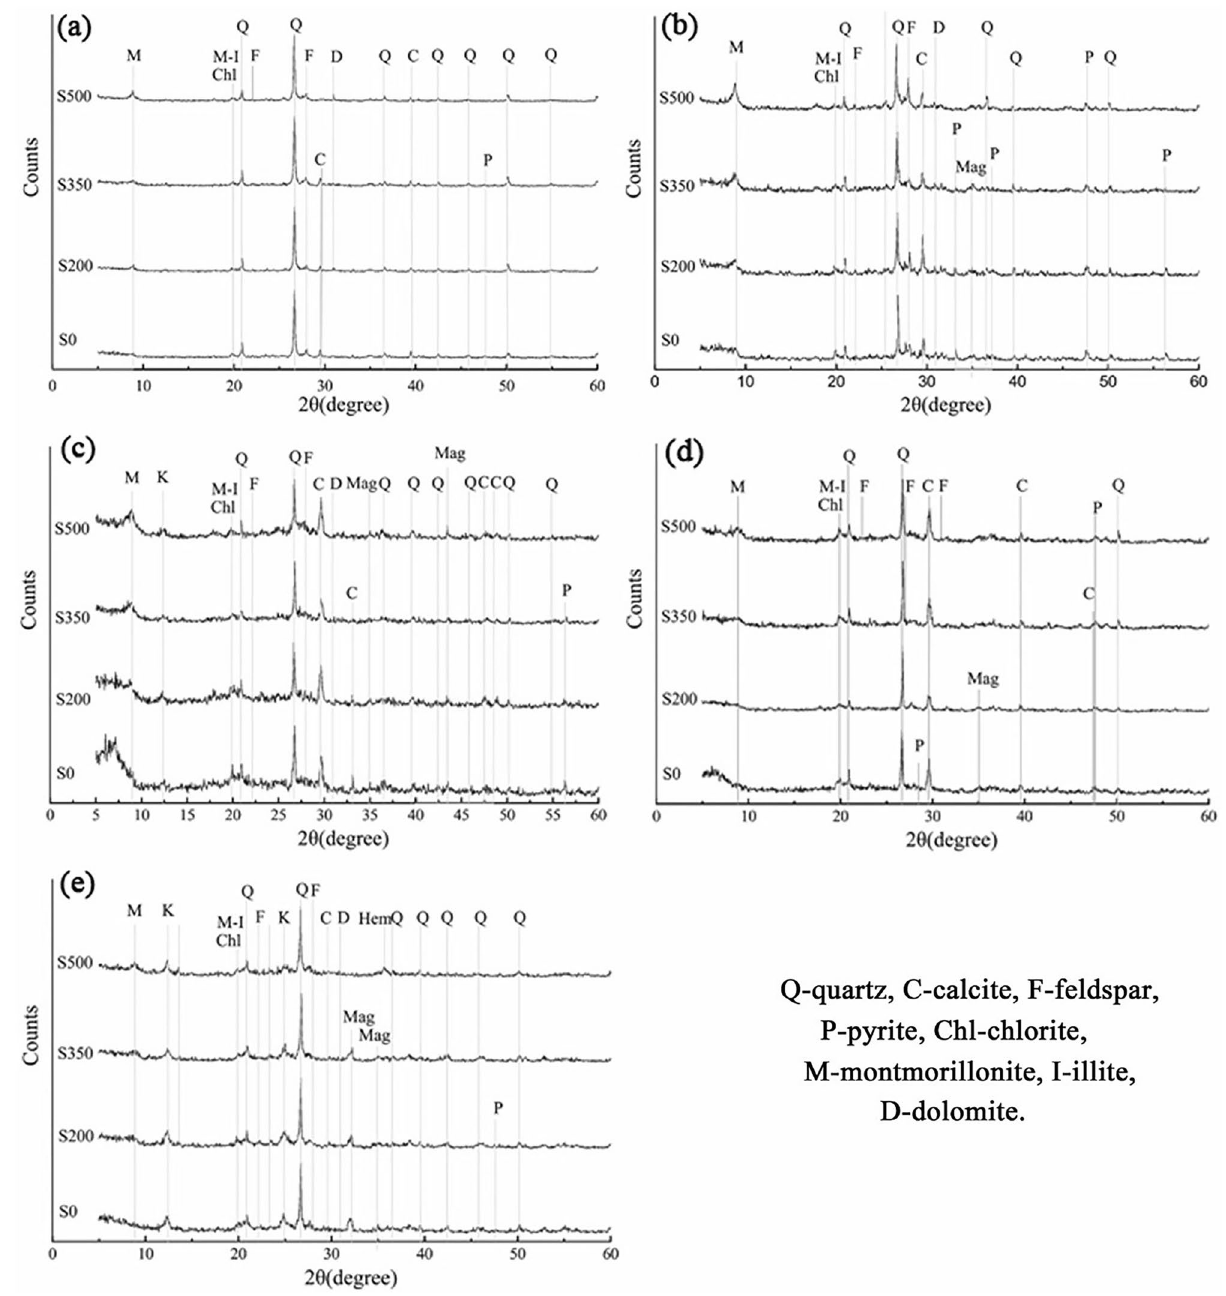
Figure 2. X-ray diffraction data of five